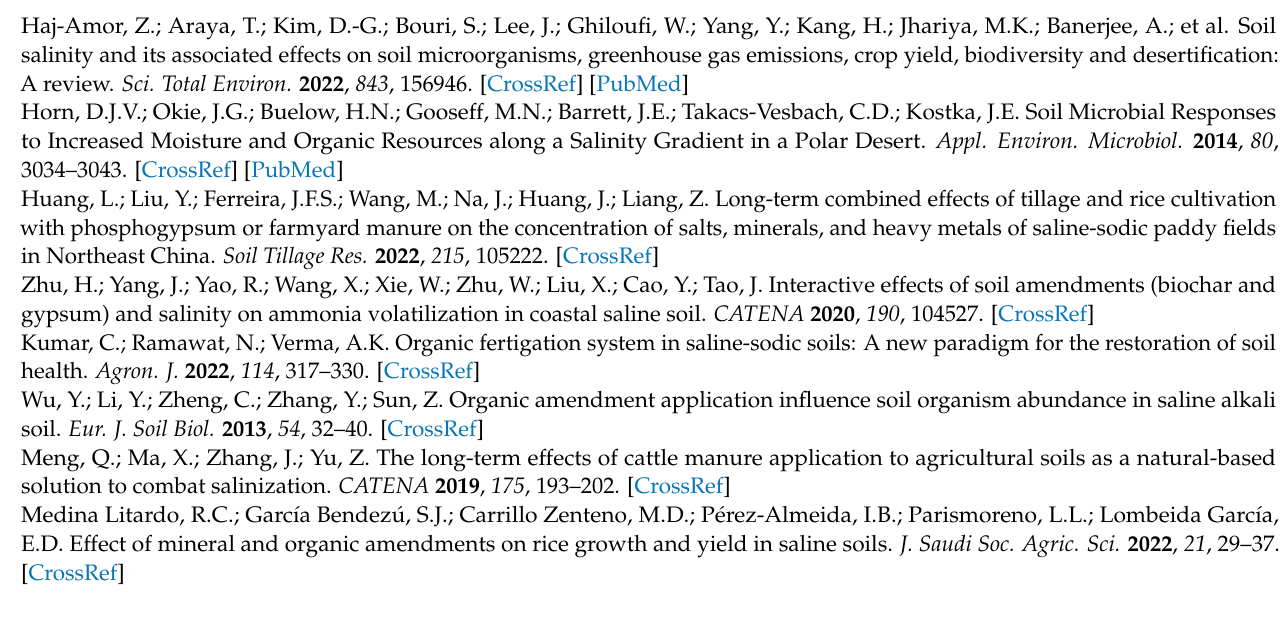
Figure S2: Pie chart of mean abundance at different phylum levels across all treatments; Figure S3: Bacterial diversity sparse curve; Table S1: Relative abundance of dominant bacteria in soil samples with different treatments; Table S2: Results of Adonis test to analyze the effects of different treatments on soil bacterial community